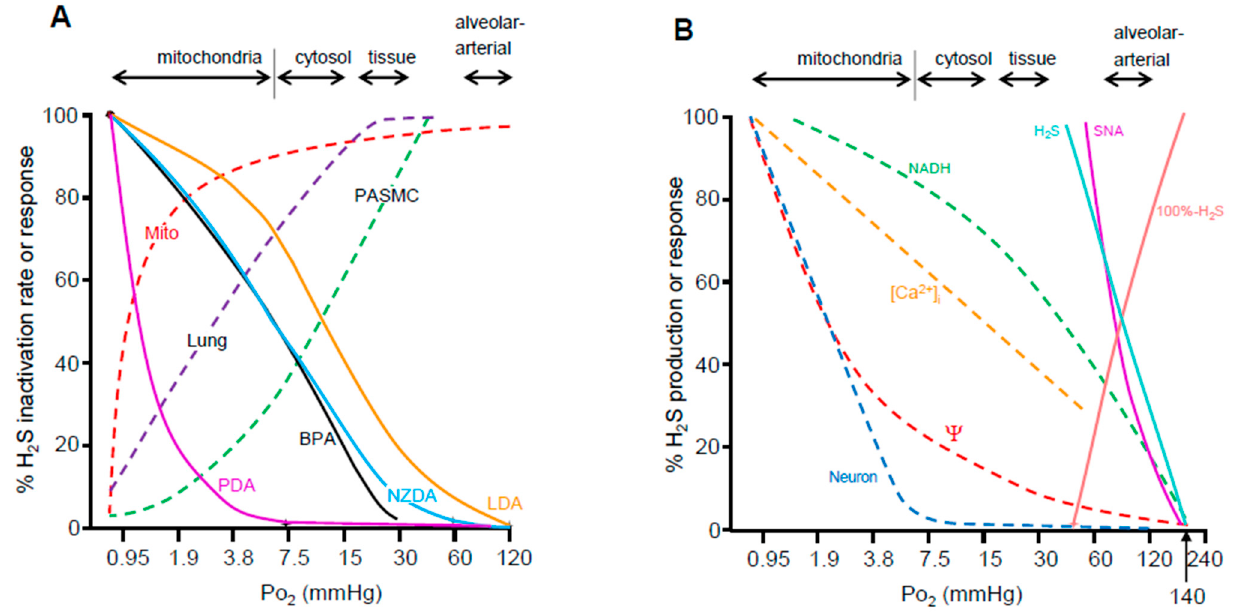
Figure 4. ( A ) Oxygen sensitivity of putative O 2 -sensing systems as a function of approximate range of oxygen tension (P O 2 ) in blood, tissues, and intracellular compartments (arrows). These are compared to O 2 sensitivity of H 2 S oxidation (inactivation) by homogenized bovine lung (Lung), pulmonary arterial smooth muscle cells (PASMC) and bovine heart mitochondria (Mito) indicated by dashed lines. Solid colored lines show physiological responses (hypoxic vasoconstriction) of bovine pulmonary arteries (BPA), lamprey dorsal aorta (LDA), and dorsal aortas from New Zealand and Pacific hagfish (NZDA and PDA, respectively) as a function of P O 2 . The H 2 S oxidation and O 2 sensitivity of tissue H 2 S consumption is similar to O 2 sensitivity in vessels from oxygen sensitive vertebrates (bovine, lamprey and New Zealand hagfish), whereas O 2 sensitivity in Pacific hagfish aortas is considerably lower commensurate with their tolerance to hypoxia. The P O 2 values at which H 2 S metabolism is impaired are at the low end of cytosolic and mitochondrial P O 2 s and would be expected during hypoxia. It is evident that the efficacy of H 2 S oxidation mechanisms correlates well with physiological responses. ( B ) Comparison of the O 2 sensitivity of afferent sinus nerve activity from the carotid body (SNA) to H 2 S production (H 2 S; or its calculated inverse, 100%-H 2 S) and components of intracellular signaling in the carotid body (solid lines). The P O 2 of the half-maximal response (P 50 ) for activation of the carotid is essentially identical to the P 50 for H 2 S production which is more evident when the latter is expressed as the inverse (100%-H 2 S). The P 50 for intracellular excitation events such as, mitochondrial NADH, intracellular calcium ([Ca 2+ ] I ), mitochondrial transmembrane potential ( Ψ ) or activation of sympathetic neurons (Neuron; dashed lines) are well below the P 50 s of the intact carotid body or H 2 S production. ( A ) Adapted from [10,88], with permission. ( B ) Adapted from [86], with permission and drawn from data in [87]. Reproduced with permission from Kenneth R. Olson et al. [10]. Reproduced with permission from Kenneth R. Olson et al. [88].